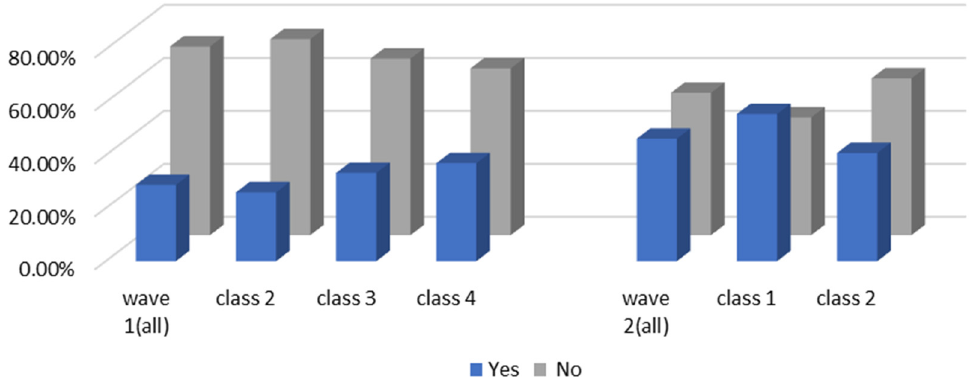
Figure 7. Car purchase intention of the carless cohort in two waves.